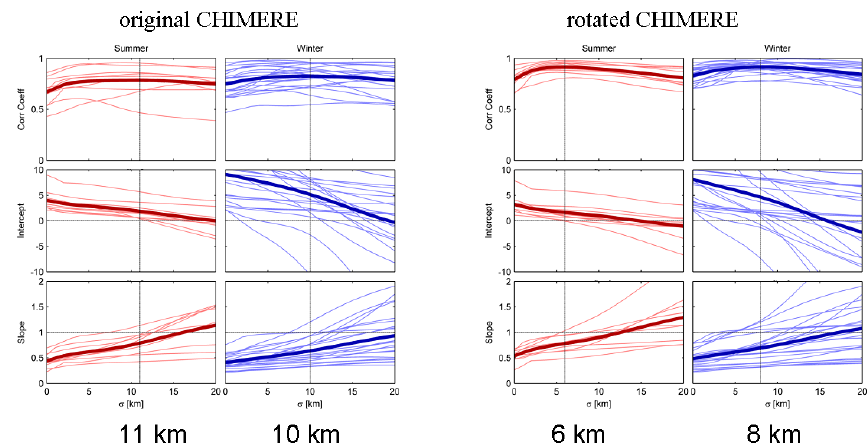
Figure 10. Same as Fig. 9, but for 24 January 2010.